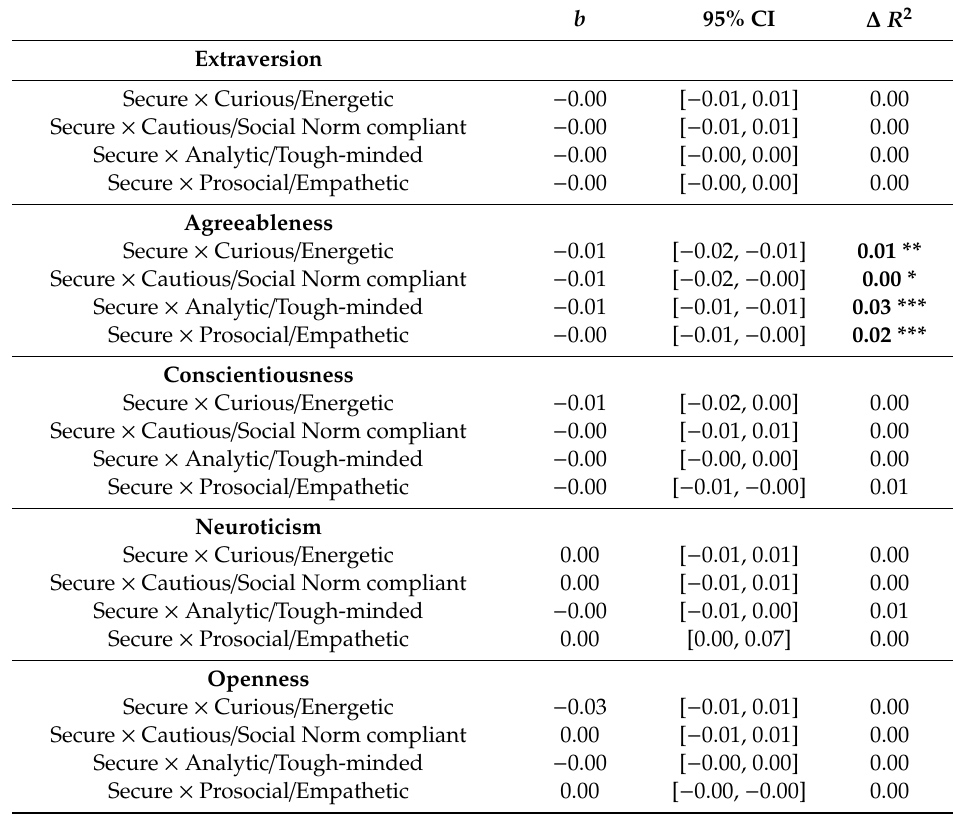
Table 3. Multiple regression models: Interactions between attachment security and temperament dimensions predicting personality traits of the Five Factor Model (FFM) controlling for sex and